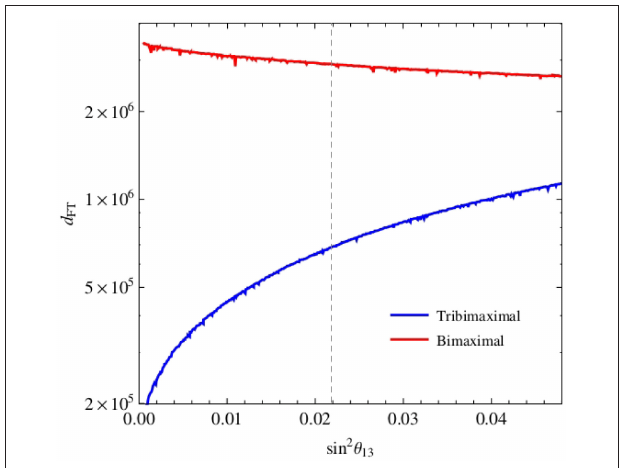
FIGURE 9 | The behavior of the d FT increases (decreases) with sin 2 θ 13 in the TBM (BM) cases. For the physical value sin 2 θ 13 larger in the BM case.